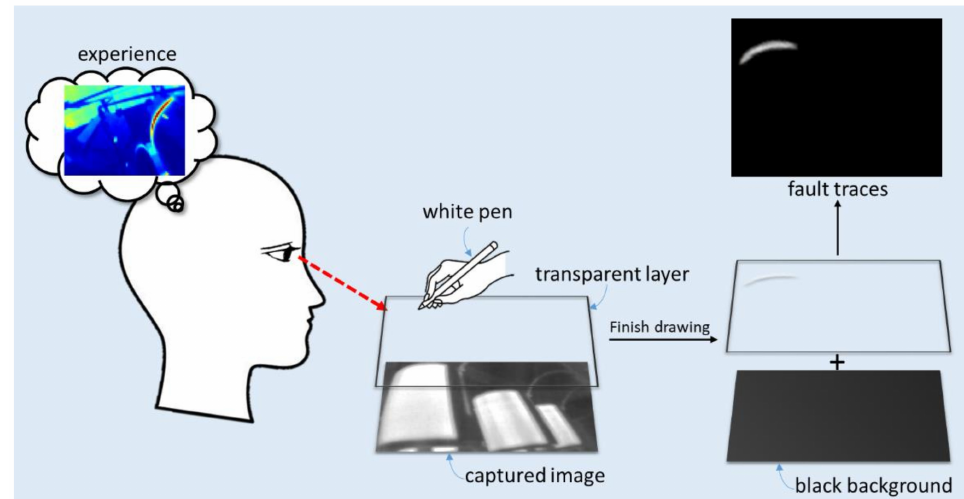
Figure 8. The fault trace making concept.